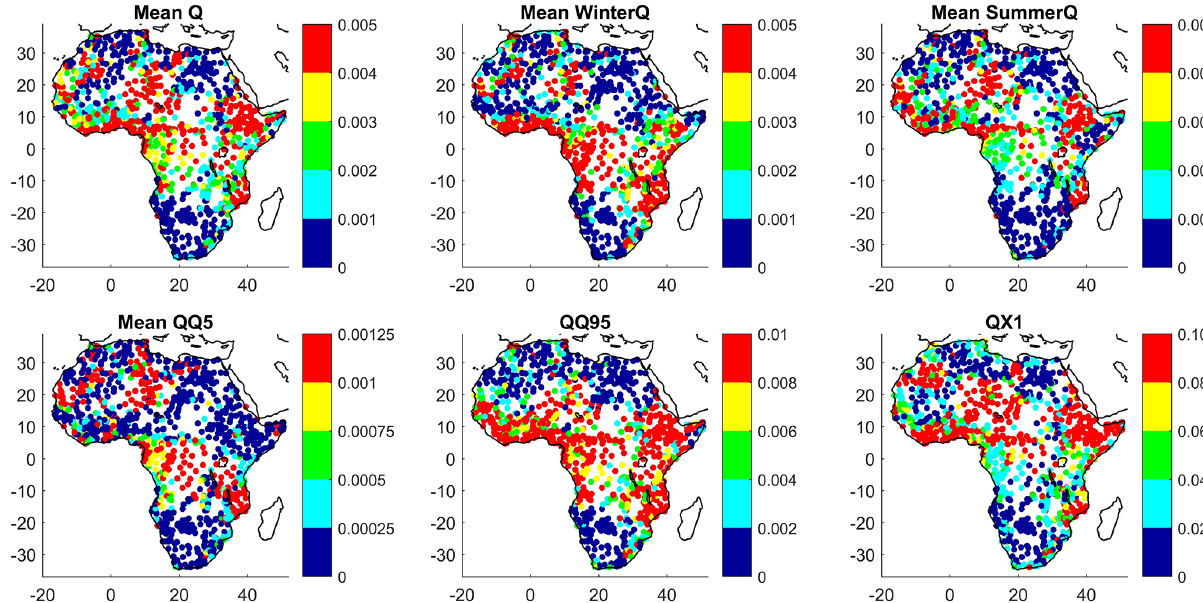
Figure 6. Standard deviation of discharge per unit area (in cubic meters per second per square kilometer), constructed from 360 values for each catchment and streamflow metric. Table 4. List of ensemble of precipitation